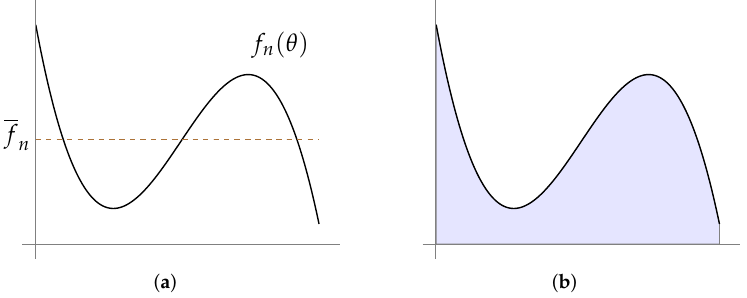
Figure 10. Case in which the ratio between the areas is an issue: ( a ) distribution given by f n ( θ ) and ( b ) area under the